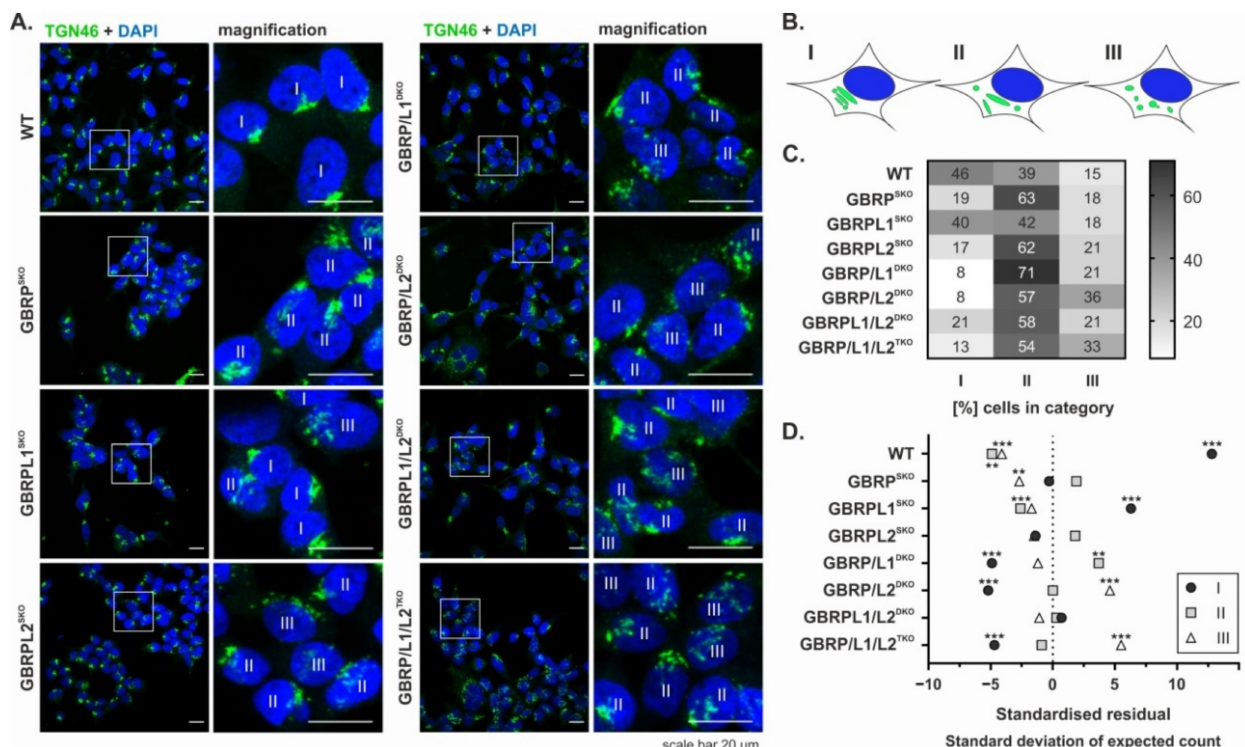
Figure 1. Influence of γ -aminobutyric acid type A (GABA A ) receptor-associated protein (GABARAP)-type protein defi- ciency on trans -Golgi morphology. ( A ) Wild type (WT) cells or cells deficient for one (SKO), two (DKO), or all three (TKO) GABARAP-type proteins (GBRPs) were fixed (4% PFA), immunolabelled with anti-human TGN46 antibody, and visualised by confocal fluorescence microscopy. Nuclei were counterstained with DAPI. Scale bar, 20 µ m. ( B ) Scheme representing the categorisation of a compact (I), partly compact (II), and dispersed (III) Golgi structure. ( C ) Heatmap of percentage of cells per cell type assigned to Golgi category I, II, and III. Per cell type, in total ≥ 188 cells from ≥ 5 individual experi- ments were analysed. Cells were categorised by visual judgement. ( D ) Standardised residual values. Asterisks indicate significant differences from the mean based on the standardised residual distribution with: |z| ≥ 2.58 ** ( p ≤ 0.01), |z| ≥ 3.29 *** ( p ≤